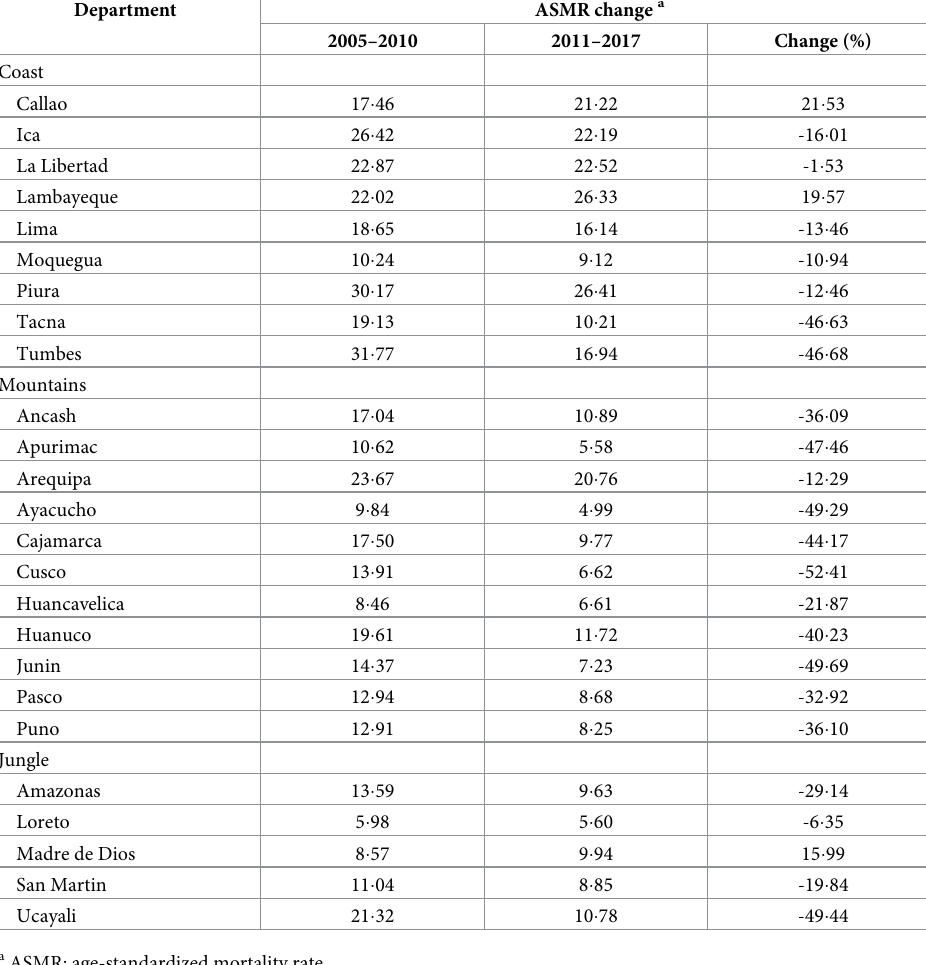
Table 1. Age-standardized mortality change (%) between two periods in Peru (2005–2010 &